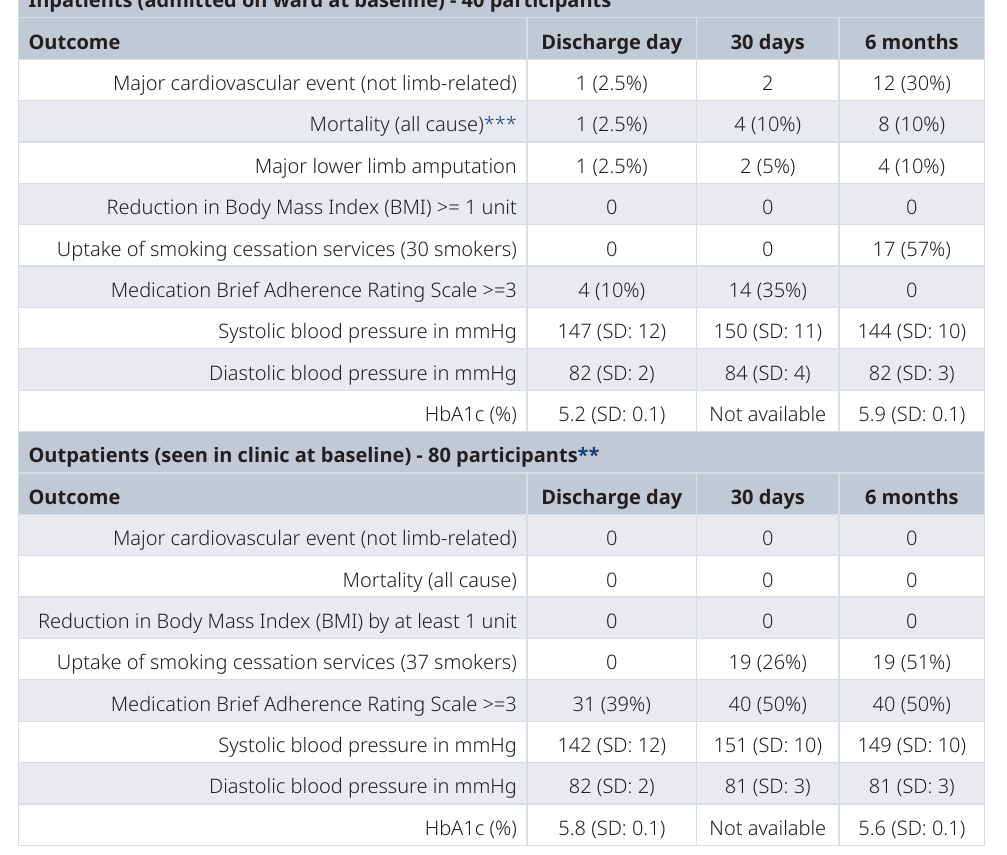
Table 5. Secondary outcome measures during